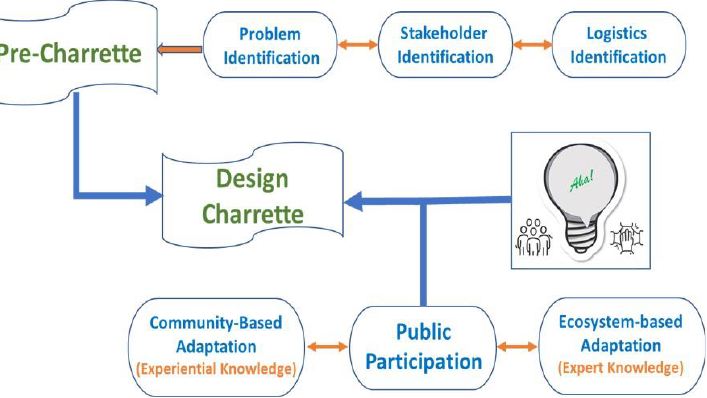
Figure 1. Simplified Charrette design as a transdisciplinary model linking ecosystem-based adaptations and community-based adaptations (Modified after Dhar and Khirfan [14]).